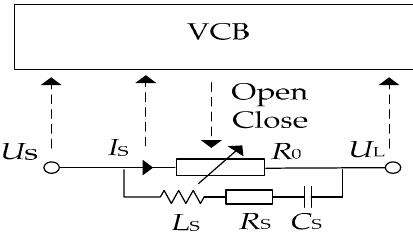
Figure 3. The vacuum circuit breaker (VCB) model diagram.